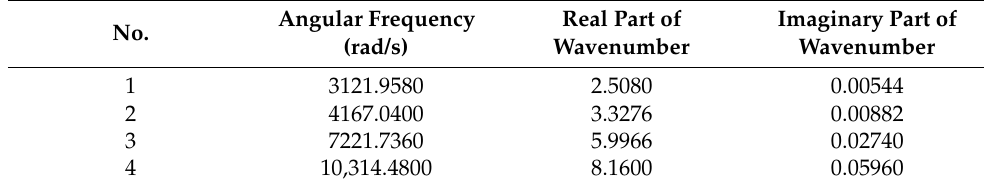
Figure 5. Test platform. Table 2. The real and imaginary parts of the test